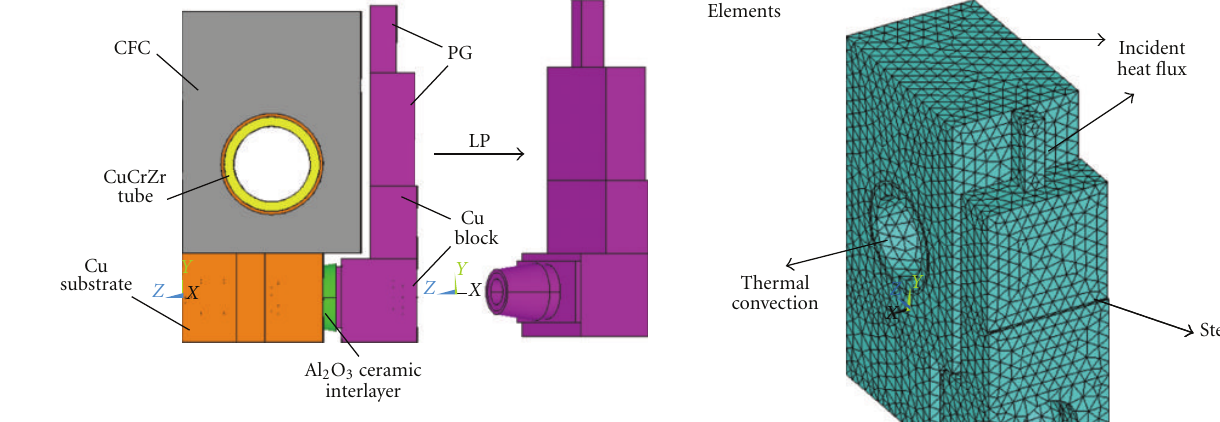
Figure 1: The composition of LP-CM used in structural analysis.